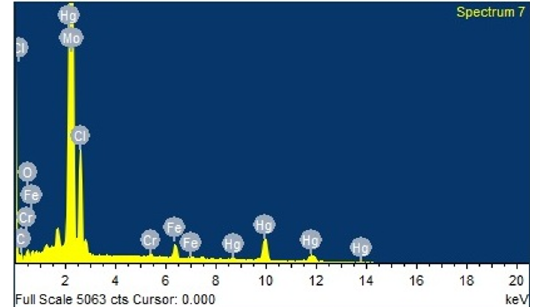
Figure 5. EDAX spectrum of MMTG